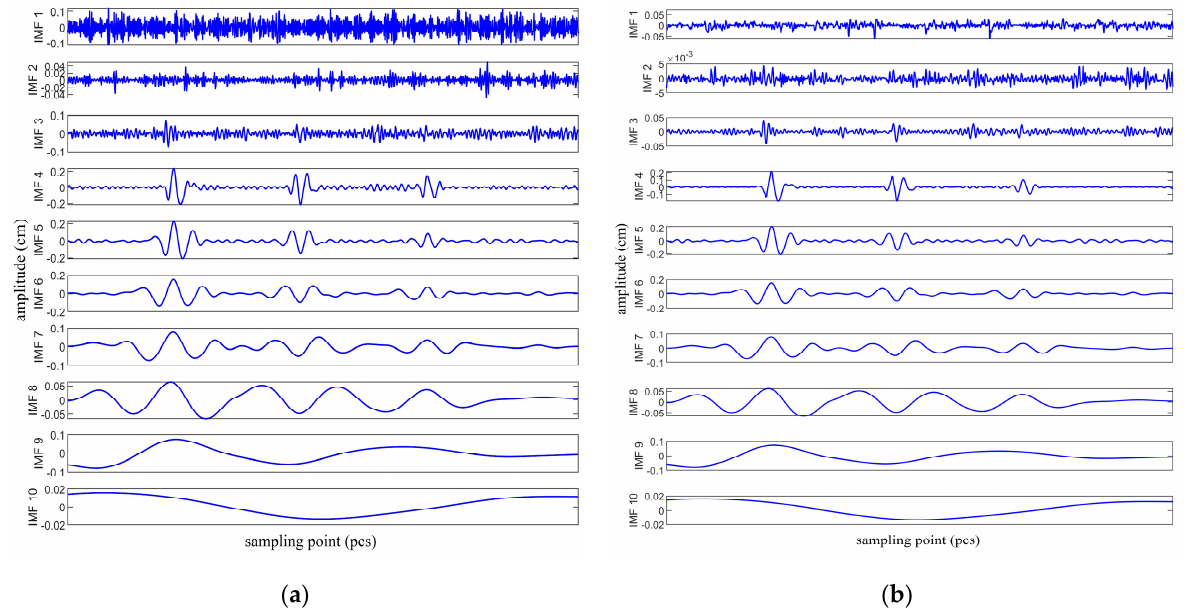
Figure 6. Comparison of IMFs before and after denoising. ( a ) IMFs before denoising; ( b ) IMFs after denoising by TFPF.